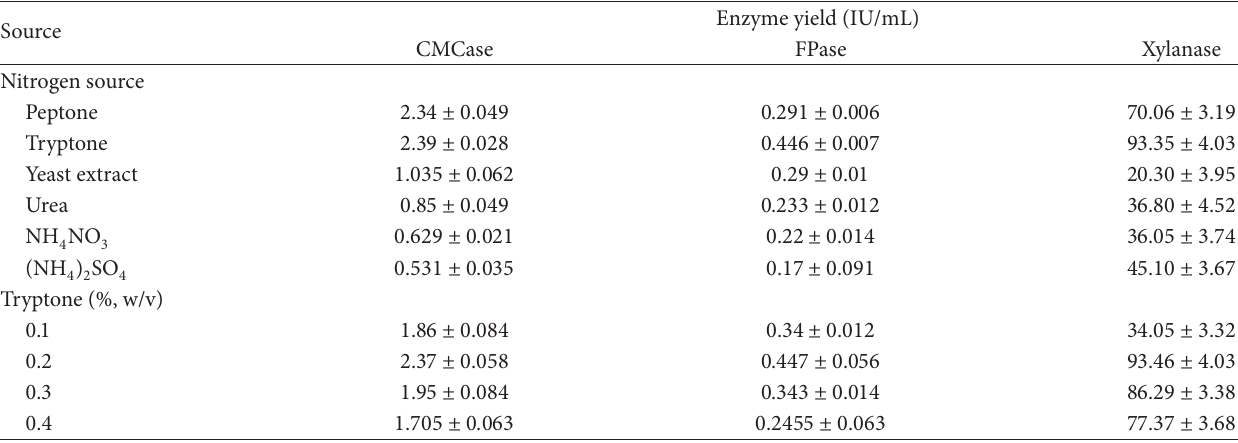
Table 2: Effect of nitrogen sources on CMCase and FPase activities. Results are presented as the mean of three replicates with standard deviation.